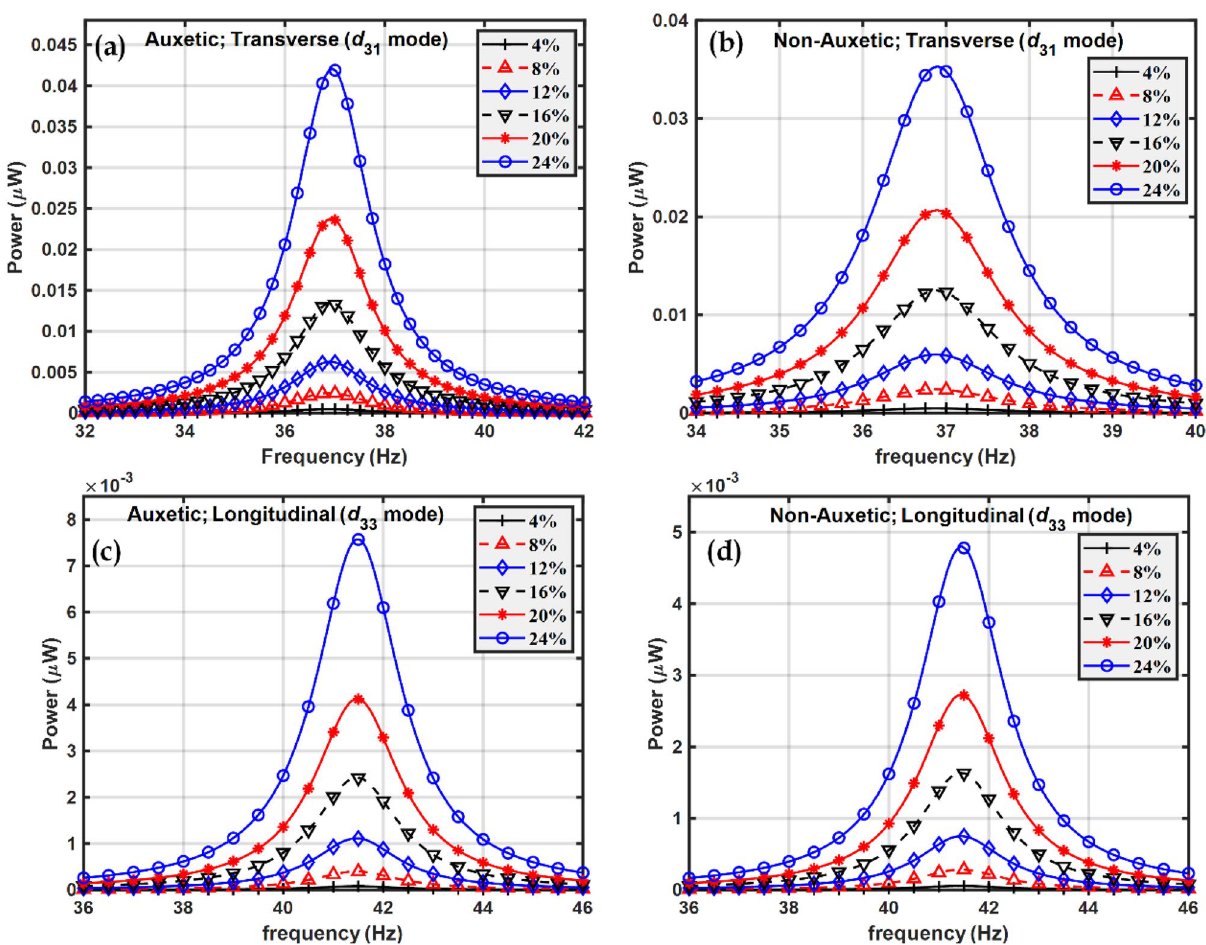
Figure 11. Power in the frequency domain at different volume fractions of BCZT in transverse ( d 31 ) mode for ( a ) Auxetic and ( b ) Non-auxetic piezocomposite; and in longitudinal ( d 33 ) mode for ( c ) auxetic and ( d ) non- auxetic piezocomposite.